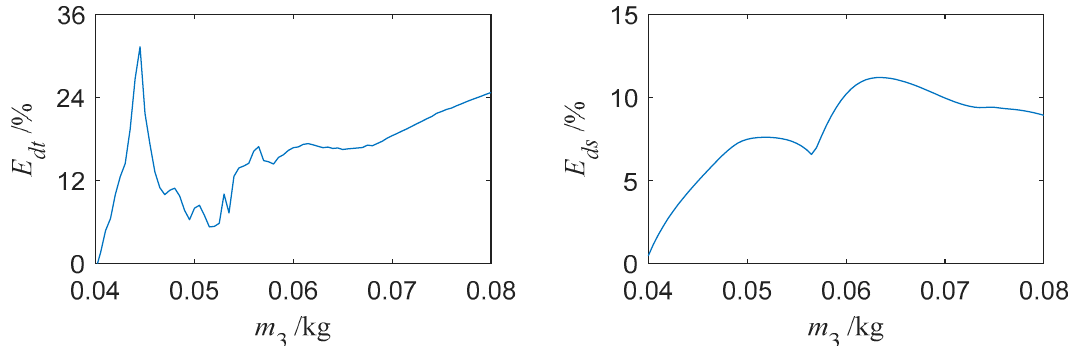
Figure 11. The influence of damper mass on the vibrational power reduction.